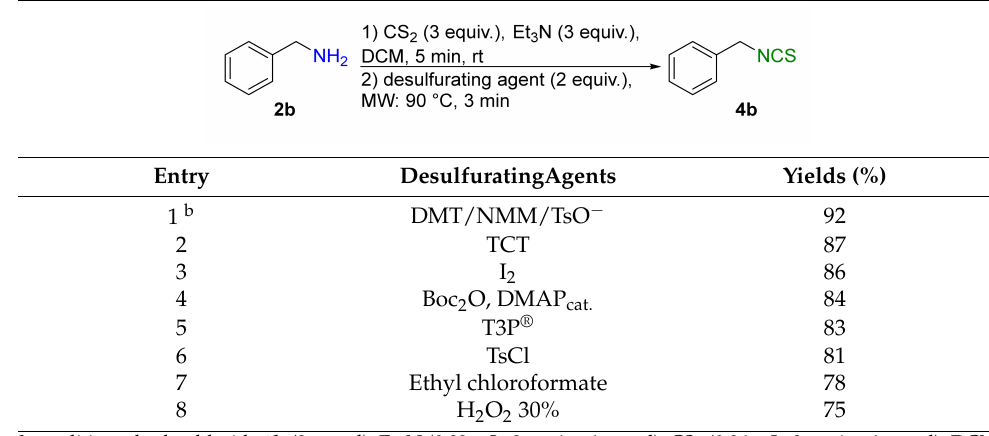
Table 4. Comparison of the efficiency of DMT/NMM/TsO − with selected desulfurating agents in synthesis benzyl isothiocyanate ( 4b ) a